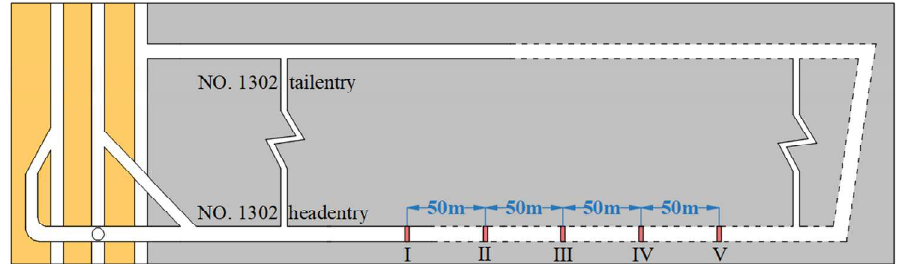
Figure 17. Layout of mine pressure monitoring